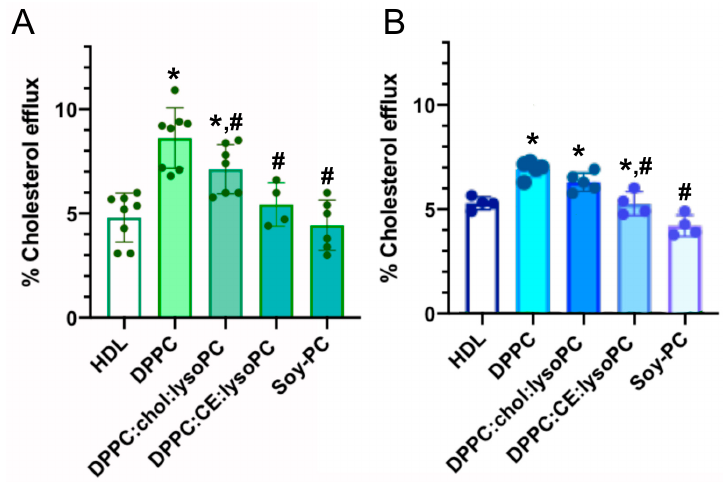
Figure 3. Effect of HDL, DPPC, DPPC:Chol:lysoPC, DPPC:CE:lysoPC and Soy-PC rHDLs on cholesterol efflux in ( A ) human THP-1 and ( B ) murine J774A.1 derived macrophages. rHDLs were added to the